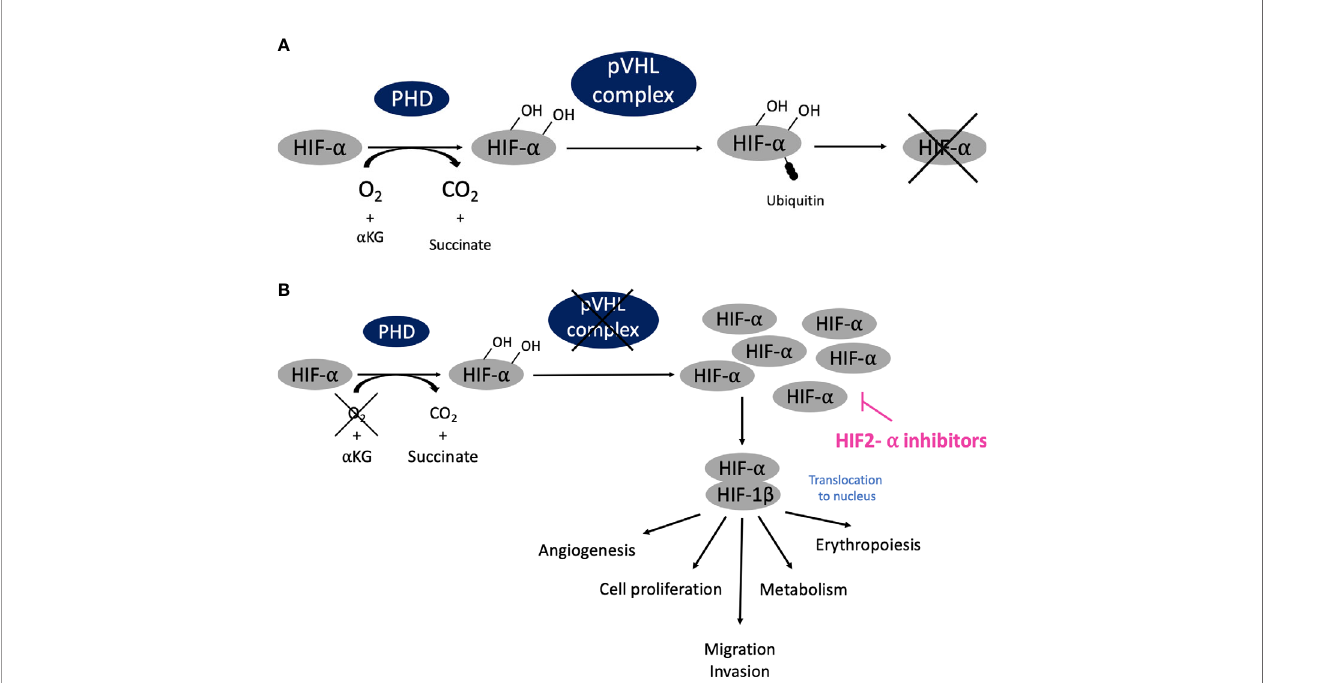
FIGURE 3 | Oxygen sensing pathway, connection with phakomatoses (VHL) and therapeutic developments. (A) In normoxic conditions (normal oxygen concentration), HIF- a are hydroxylated on proline residues by prolyl hydroxylase, is then recognized by pVHL complex and ubiquitinated and subsequently degraded via the proteasome. (B) In hypoxic conditions (low oxygen concentration), HIF- a cannot the be recognized by pVHL and degraded; it accumulates, dimerizes with HIF-1 b , translocates into cellular nucleus and activates transcription of targeted genes. Similarly, when VHL is mutated there is also no possibility of HIF- a degradation even in normoxic conditions, and this creates a pseudo-hypoxic state with the HIF- a /HIF-1 b dimer constantly activated, leading to the development of tumor angiogenesis as compensation.